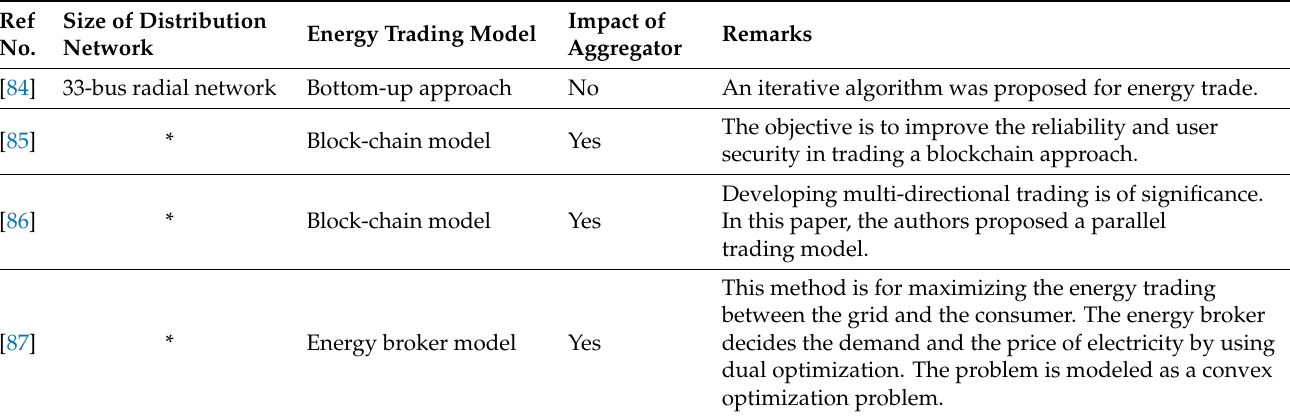
Table 5. Energy trading models.